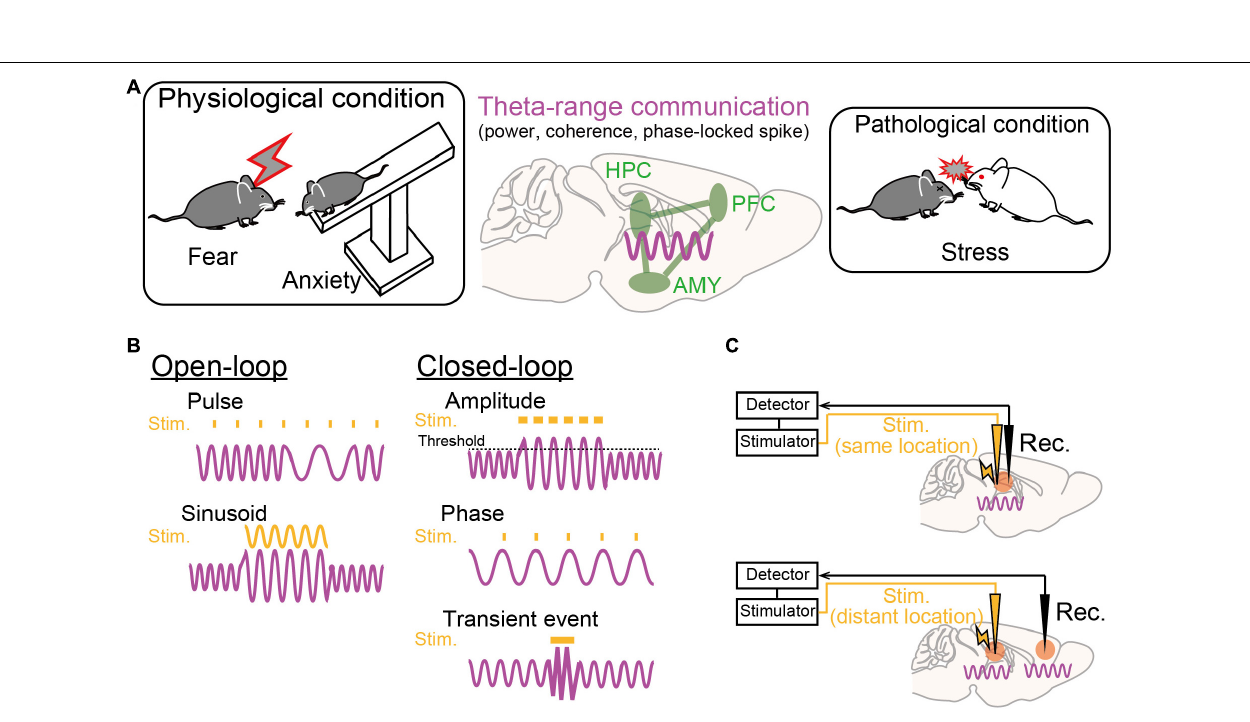
Frontiers in Behavioral Neuroscience |